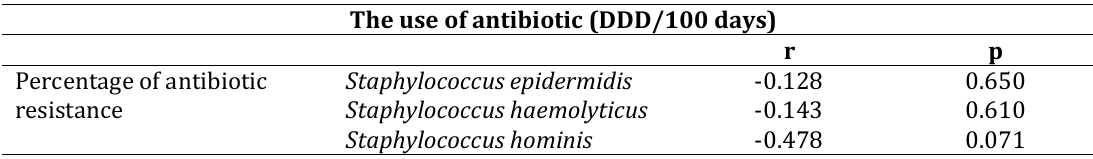
Table II. Correlation between antibiotic use and antibiotic resistance The use of antibiotic (DDD/100